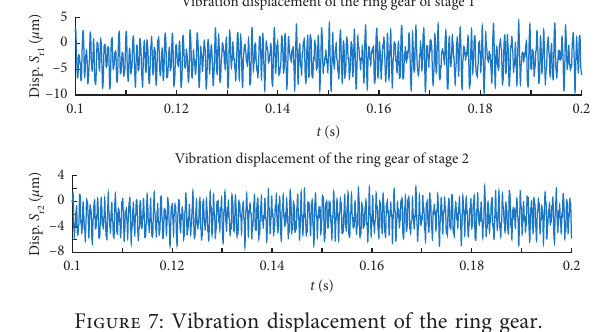
Figure 7: Vibration displacement of the ring gear.